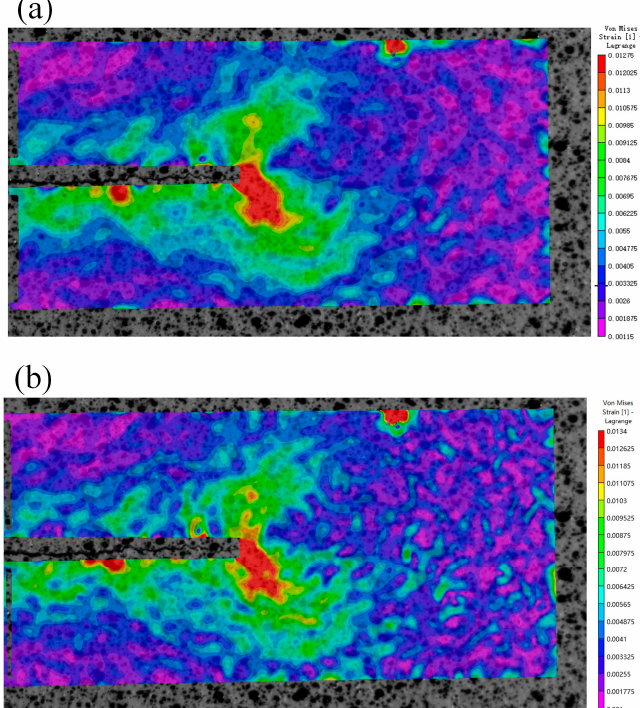
Figure 18. ( a ) The results of the strain field calculated by the template matching reference image; ( b ) the results of the strain field calculated by the reference image of the original acquisition.